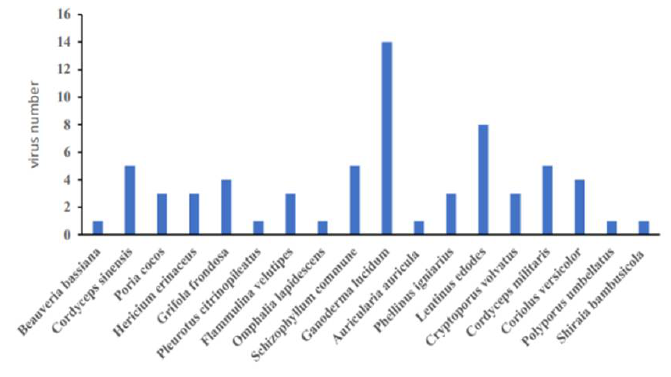
Figure 4. Medicinal fungi can resist the virus number in this review.